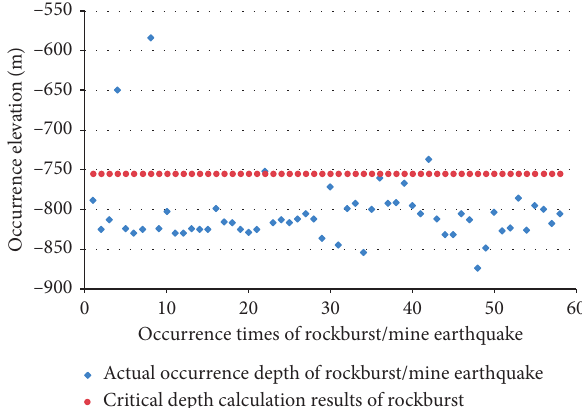
Figure 5: Calculation results for critical depth of rockburst in panel